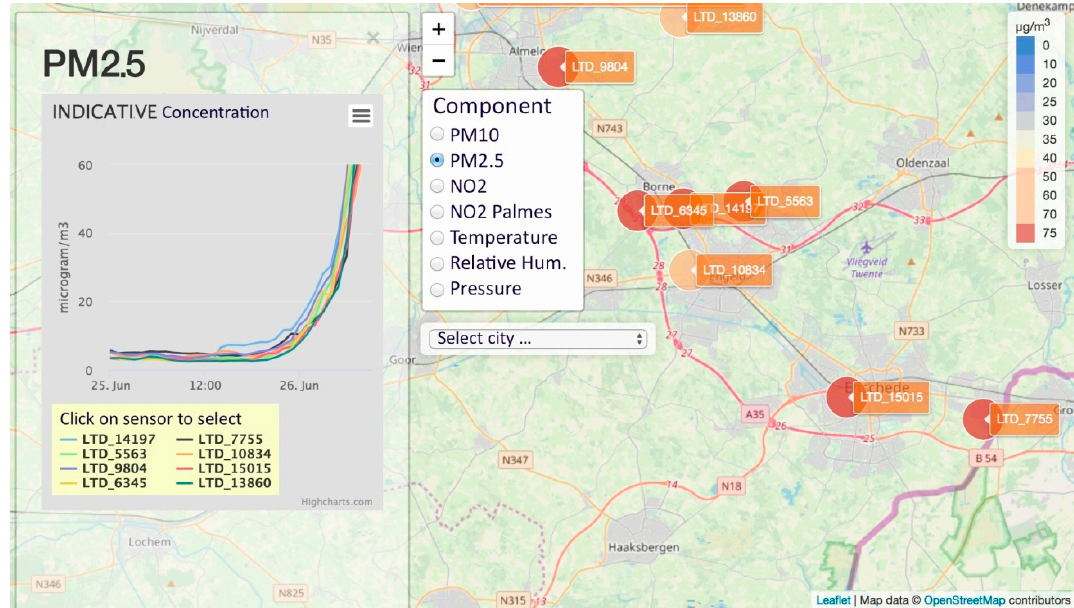
Figure 9. View of the “Measuring Together” data portal (samenmeten.rivm.nl) after zooming to almost street level, example from 26 June 2019, when the figure was shown on the data portal. The individual results of all sensors in the view (when less than 10) are presented. The eight sensors shown in the left panel all show strongly increasing PM 2.5 concentrations over the last 12 h.